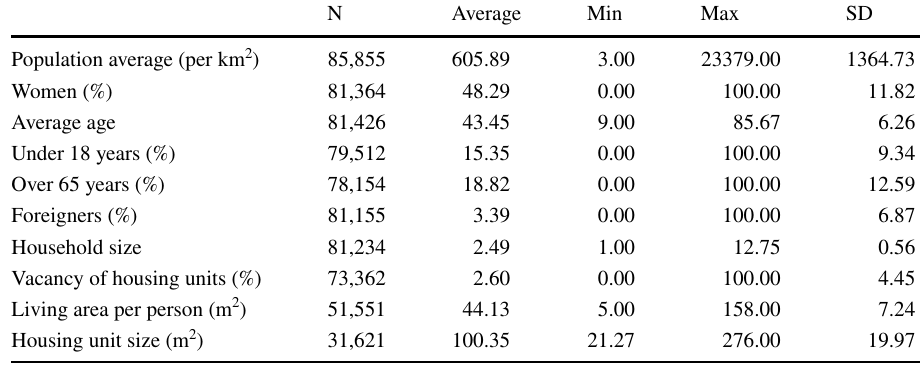
of the census data used for the assessment of spatial industrial accident exposure and social vulnerability in Germany